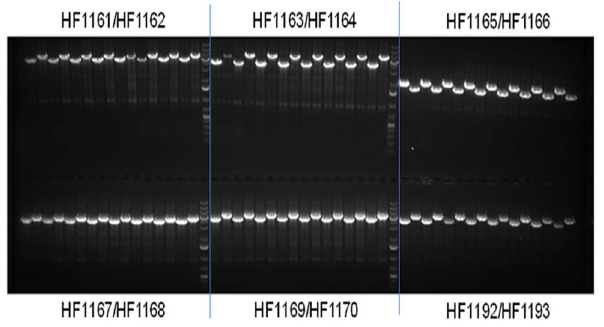
Fig. 5. PCR screening of multi-fragment assembled clones from Table 3. Eight clones (colonies) from each construct were grown overnight in the 96-well plate containing LB + Spectinomycin (50 ug/ml). One m l of the over-night grown cell culture was used for PCR screening with base vector primers (18 bp) located immediately upstream of the promoter and downstream of the terminator. PCR products for each construct were loaded every other lane on a 1.0% agarose gel (containing ethidium bromide) with a multi channel pipette. GeneRuler 1 kb Plus DNA Ladder was used as the DNA marker.